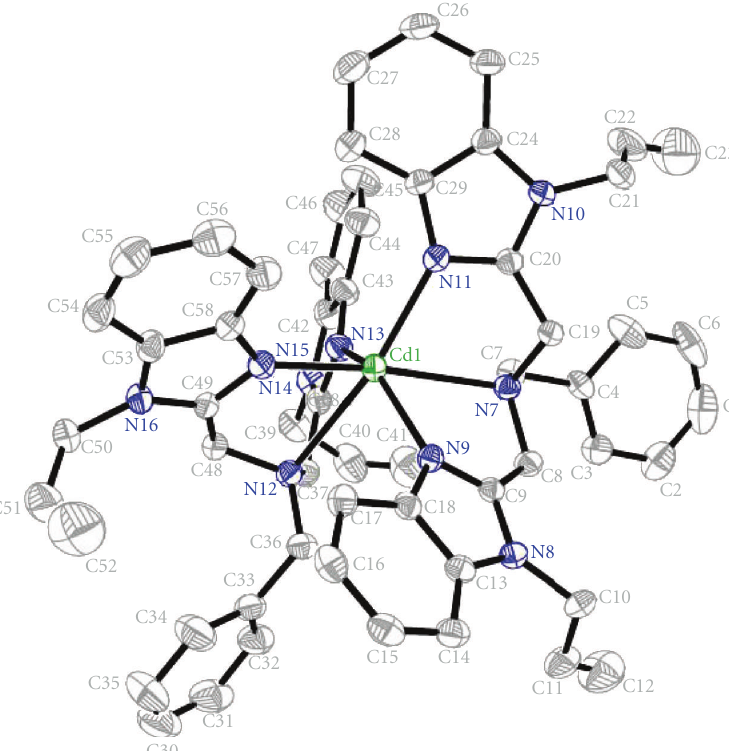
Figure 1: Molecular structure and atom-numberings of [Cd(babb) 2 ] 2+ with hydrogen atoms omitted for